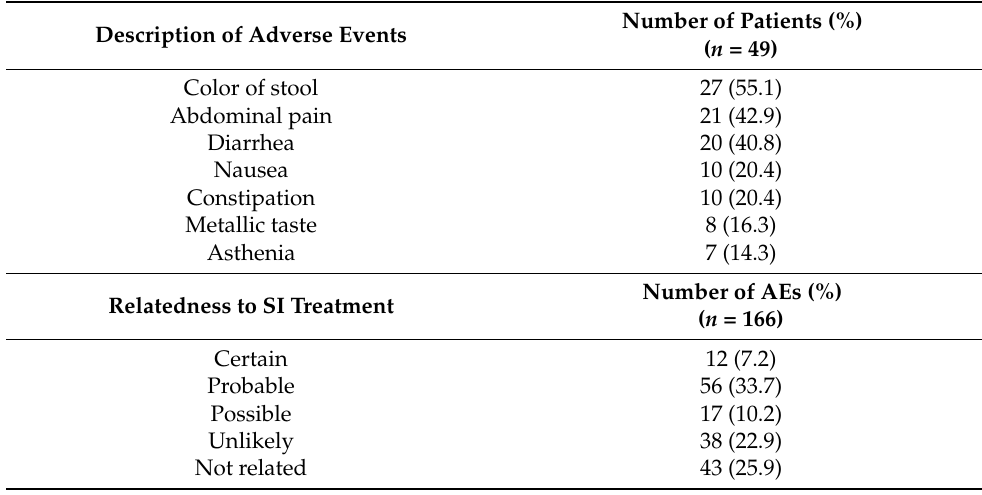
Table 3. Description of most frequent adverse events reported and relatedness of all adverse events to Sucrosomial ® iron treatment.